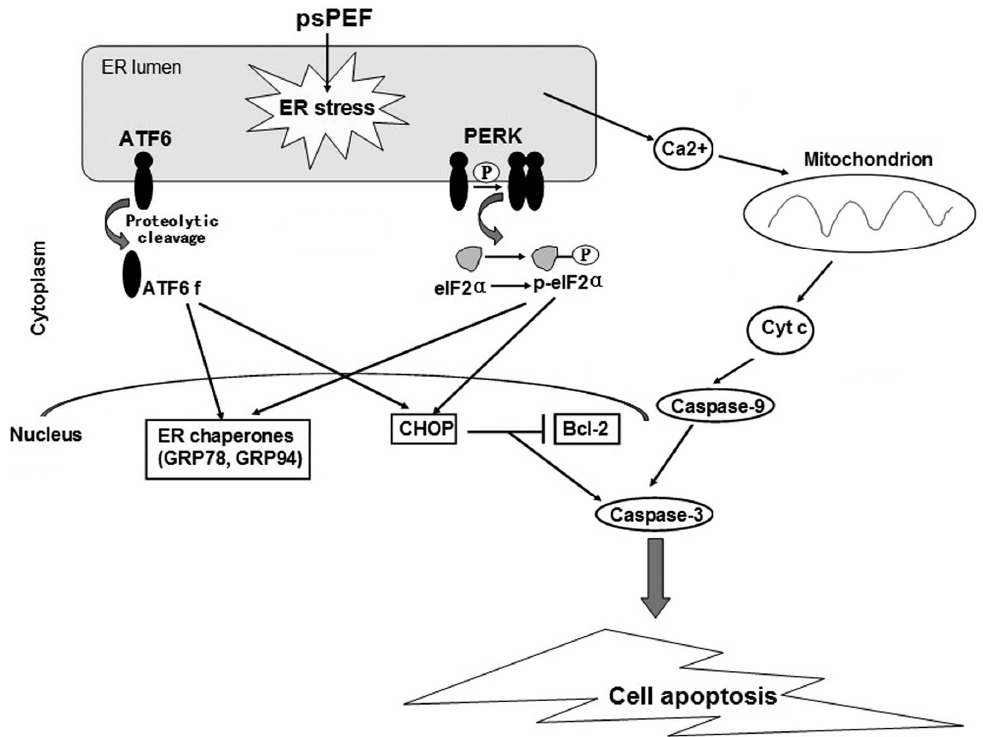
Figure 6. Scheme of the signaling network through which a picosecond pulsed electric field (psPEF) induces apoptosis in HeLa cells, as proposed by Chen et al. The pulses disturb the endoplasmic reticulum (ER) function, resulting in the release of Ca 2+ and the depolarization of mitochondria, which in turn release cytochrome C (cyt c) and activate the caspase family. The ER dysfunction also causes two of its transmembrane proteins, activating transcription factor 6 (ATF6) and protein kinase-like ER kinase (PERK), to activate the unfolded protein response. The ATF6 pathway promotes the expression of ER chaperones and the pro-apoptotic transcription factor CCAAT enhancer-binding protein (C/EBP) homologous protein (CHOP). Phospho-PERK instead phosphorylates eukaryotic initiation factor-2 α (eIF2 α ), which decreases gene expression. Reprinted from [170] with permission granted from the editor.